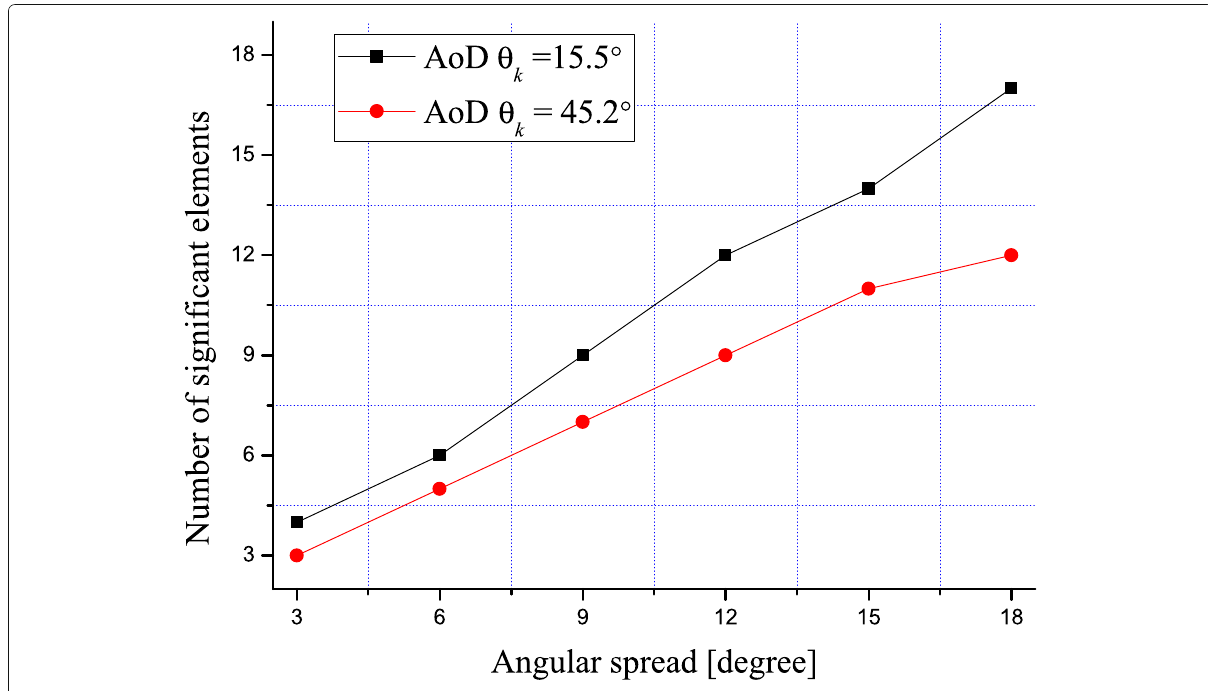
Fig. 5 Number of significant elements in x k , m , where N = 64 and M = 4